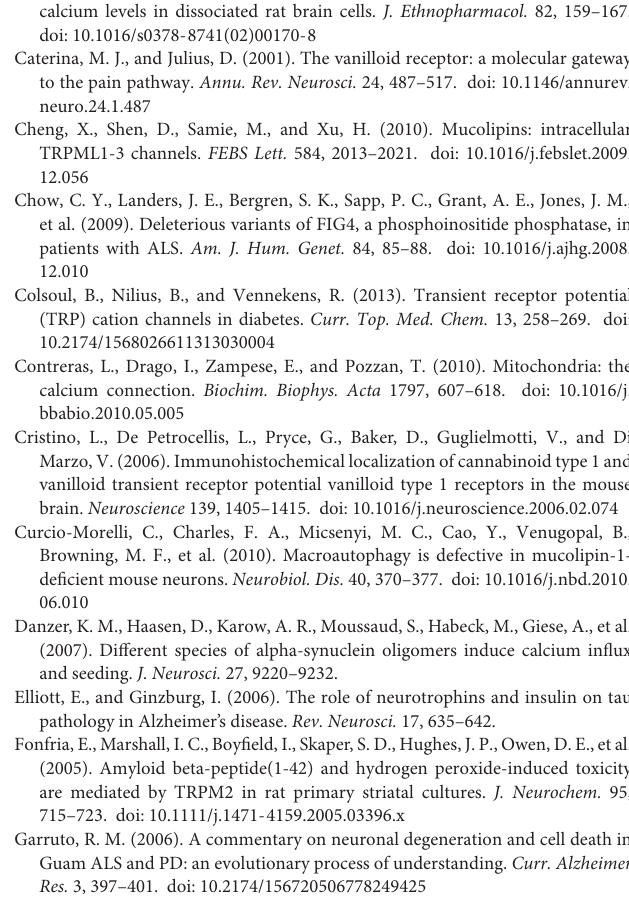
Supplementary Figure 1 | Summary of TRP subfamilies-mediated studies related to neurological disorders [modified from Nilius (2007), Hong et al. (2020b), Thapak et al. (2020)]. Different colors are used in the table for better classification and the gray boxes in the “Related Disease” column represent the roles of specific TRP subfamilies in each neurological disorders as reported in the published literature. Abbreviations : AD, Alzheimer’s disease; ALS, amyotrophic lateral sclerosis; AMG, amygdala; APP, amyloid precursor protein; BBB, blood-brain barrier; BG, basal ganglia; Bs, brainstem; CB, cerebellum; CC, corpus callosum; Cd, caudate; Cg, cingulate gyrus; CNS, central nervous system; CTX, cortex; DA, dopamine; DG, dentate gyrus; DRG, dorsal root ganglion; ER,